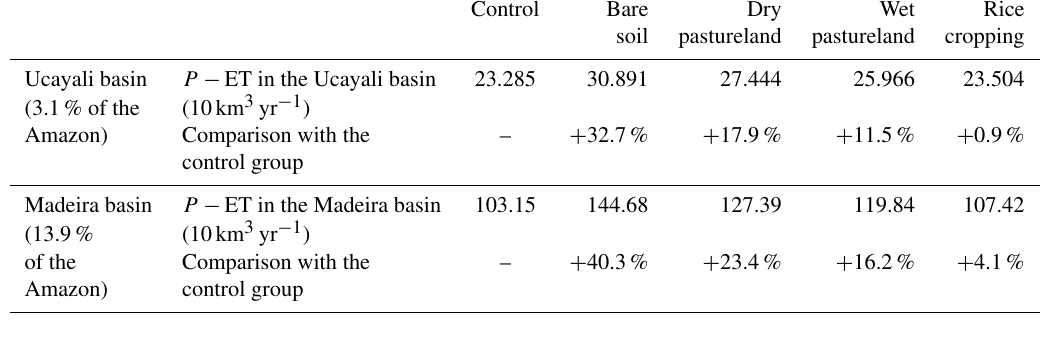
Table 5. Runoff ( P − ET) estimates in different regions under different land use scenarios.